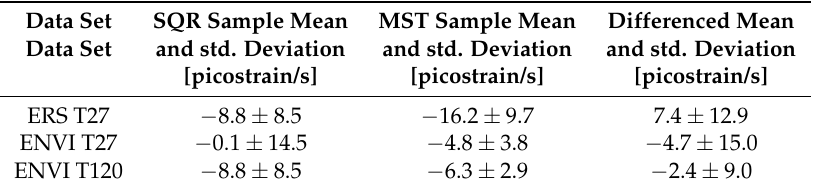
Table A3. Mean strain rates near the power plant at San Emidio as measured by SqueeSAR and estimated by time-series analysis of the MST